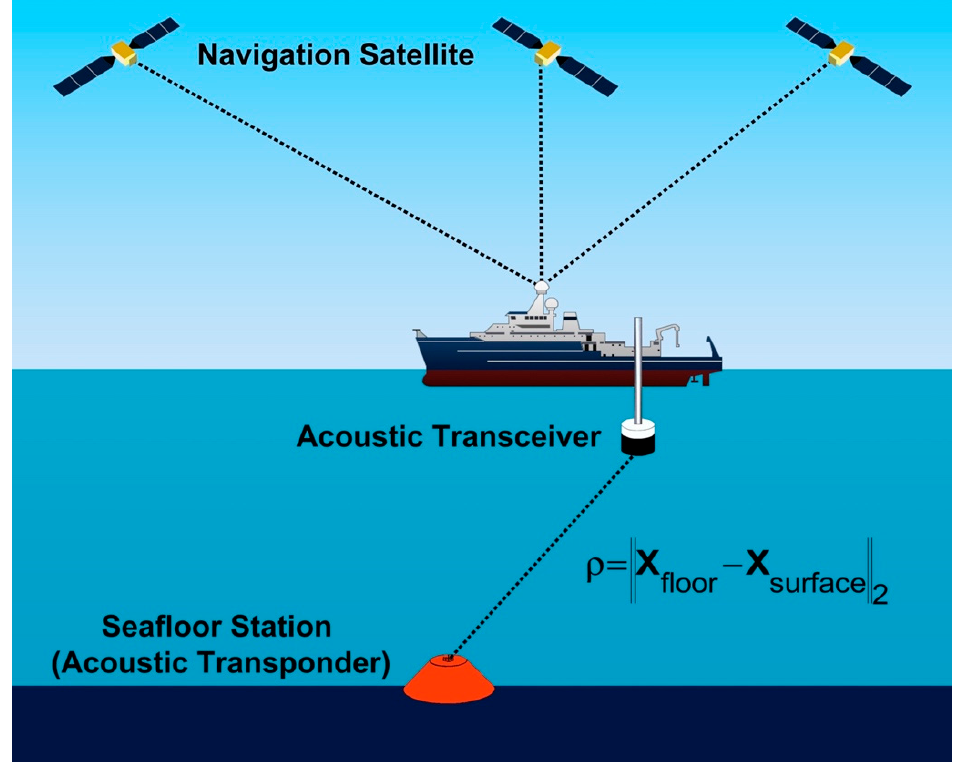
Figure 1. Principle of seafloor GNSS-Acoustic positioning.